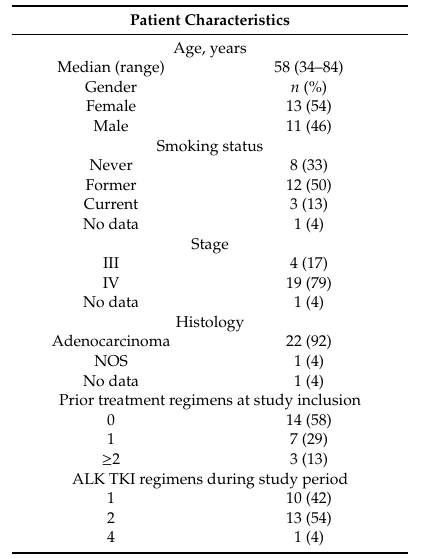
Abbreviations: NOS, not otherwise specified; ALK, Anaplastic Lymphoma Kinase; TKI, tyrosine kinase